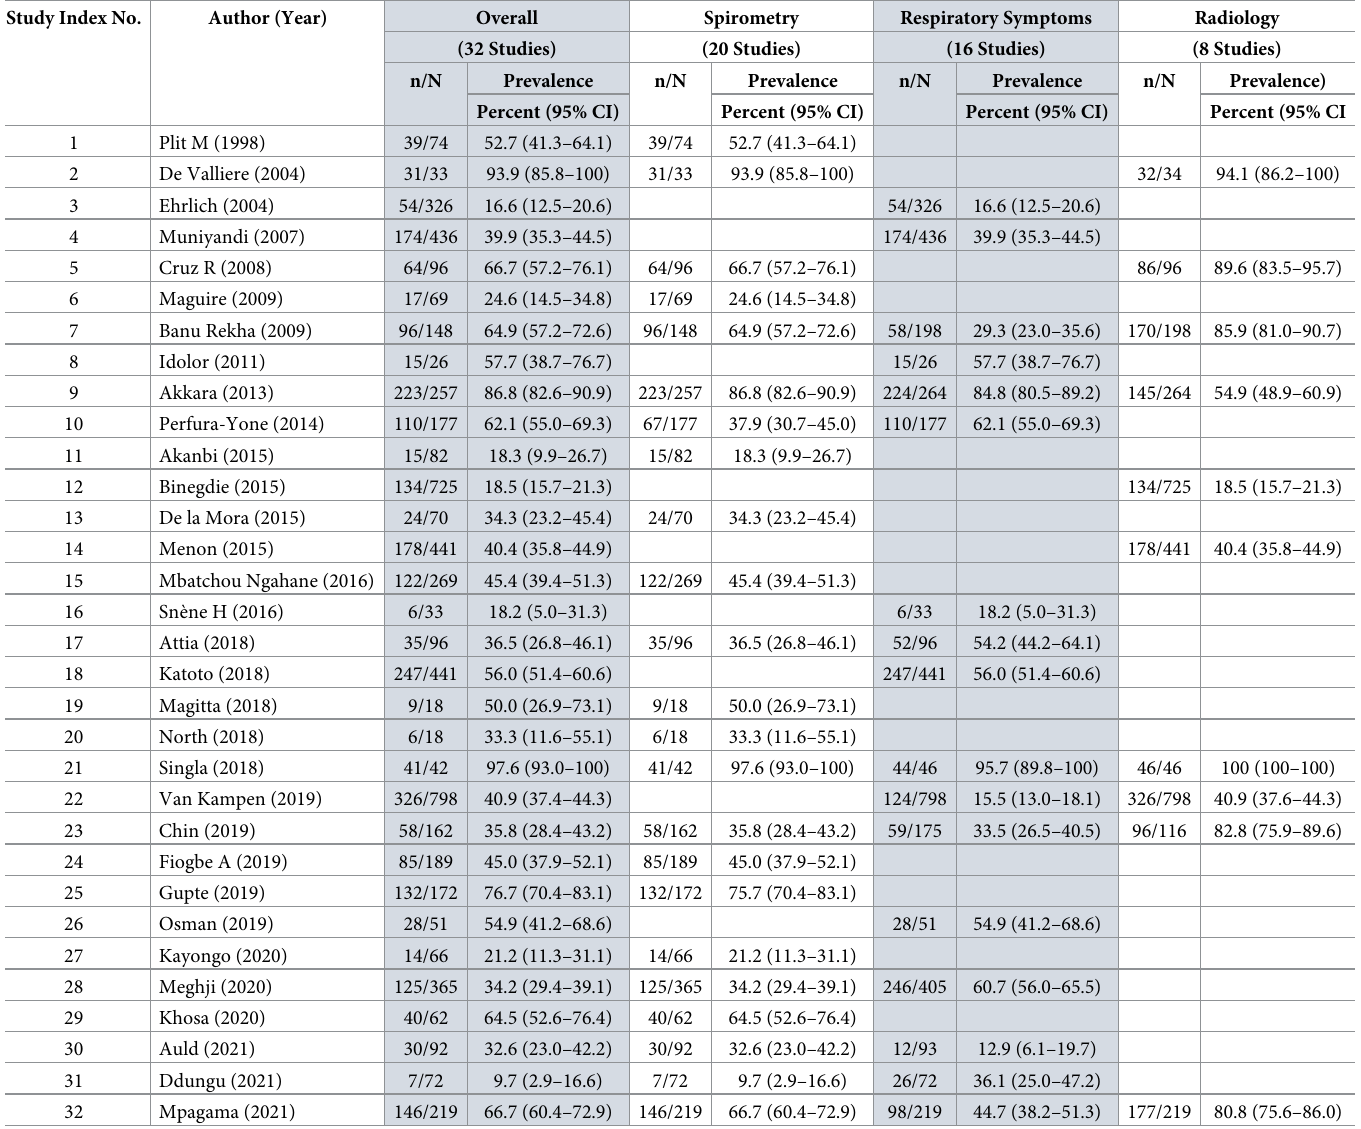
Table 2. Prevalence of post-TB lung disease–abnormal lung function, persistent symptoms, or abnormal radiology. Study Index